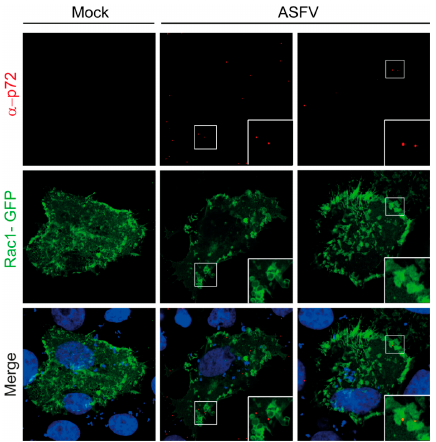
Figure 2. Rac1 localizes to ruffles during ASFV entry. Vero cells were transfected with EGFP-Rac-1 plasmid expression for 16 h and synchronously infected (adsorption period of 90 min at 4 °C) at an multiplicity of infection (MOI) of 10. Cells were fixed and incubated with Topro-3 and monoclonal antibody anti-p72 17LD3 to visualize DNA and viral particles, respectively; samples were processed by CLSM (x63 magnification). Images are representative of three independent experiments (images from D. Pérez-Núñez, E. G. Sanchez and Y. Revilla).